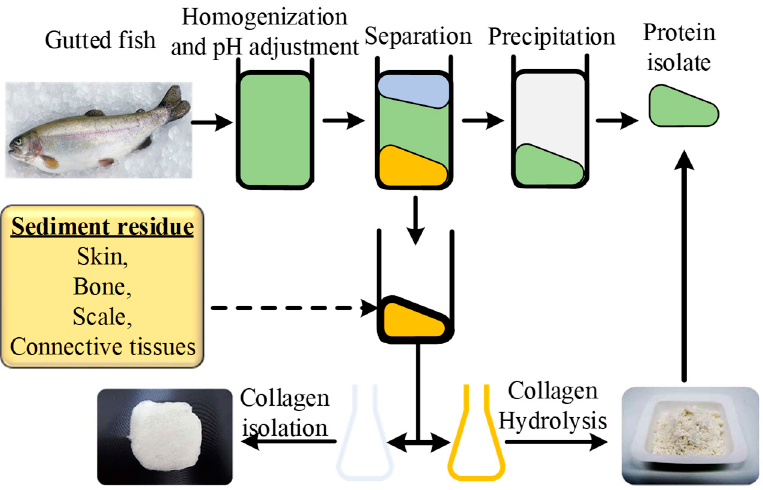
Figure 3. Sediment method for collagen extraction.